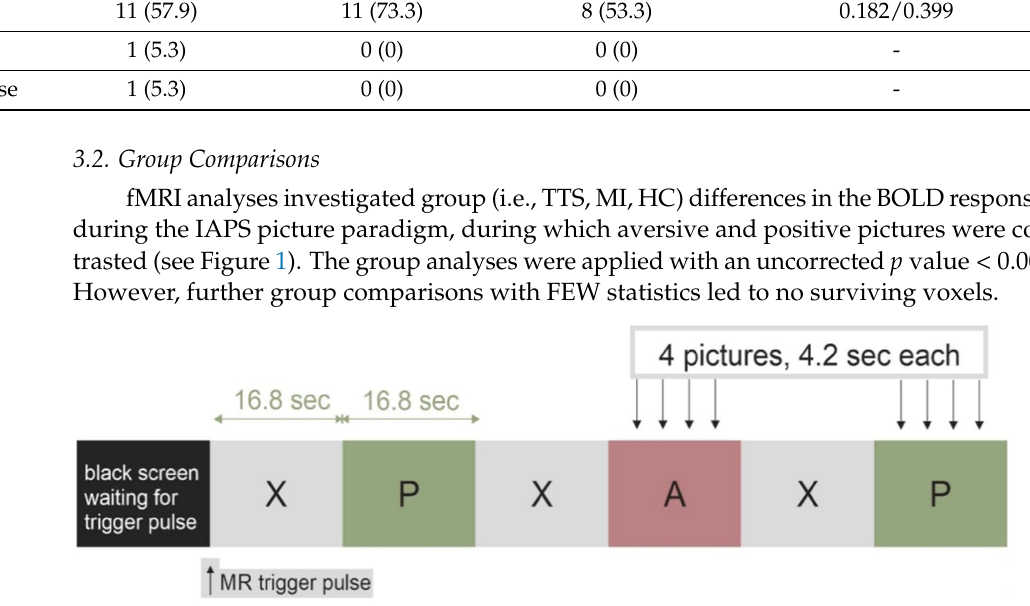
( c ) Figure 2. Group differences of takotsubo syndrome patients (TTS) and healthy controls (HC) during the emotional task-based fMRI paradigm during the decoding of aversive versus positive pictures from the IAPS. The brain images are presented in MNI space. ( a ) TTS acute phase compared to HC had significantly lower mean activity in the left inferior frontal gyrus (IFG), right thalamus, left insula,